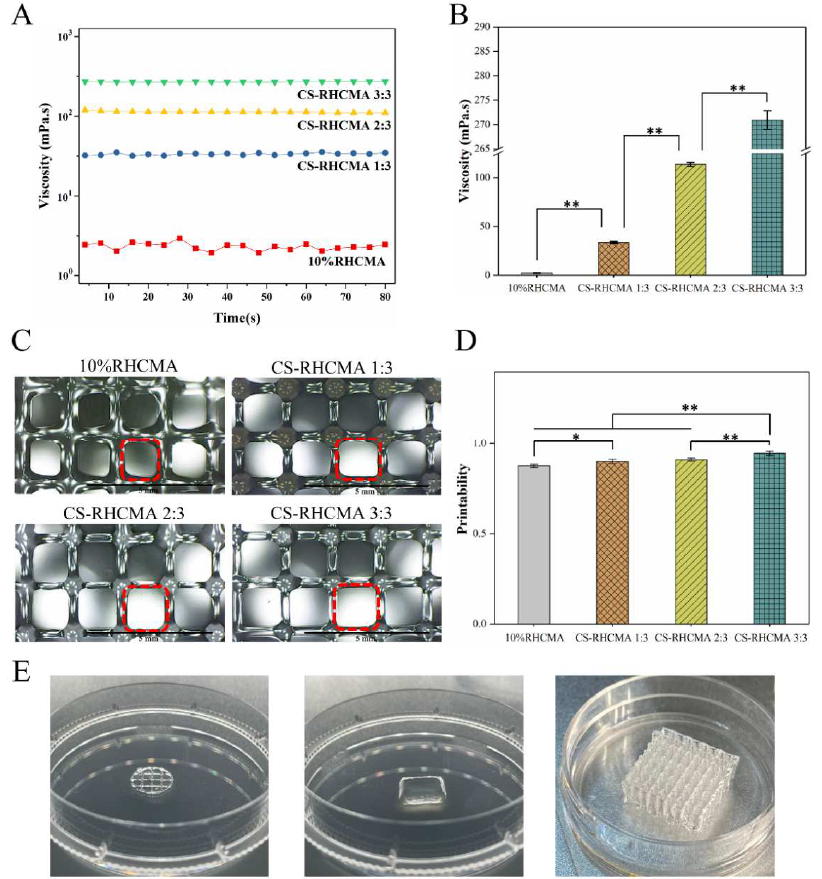
Figure 5. Viscosity and printing feasibility of RHCMA and CS-RHCMA bioinks. ( A ) Viscosity behaviors of the bioinks determined from rheological test. ( B ) Average viscosity value of the tested samples. ( C ) Optical microscope images of the printed lattices. Scale bar = 5 mm. ( D ) Determination of the printability of different bioinks. Significance is indicated with * p < 0.5 and ** p < 0.01. ( E ) 3D printed constructs different structures.